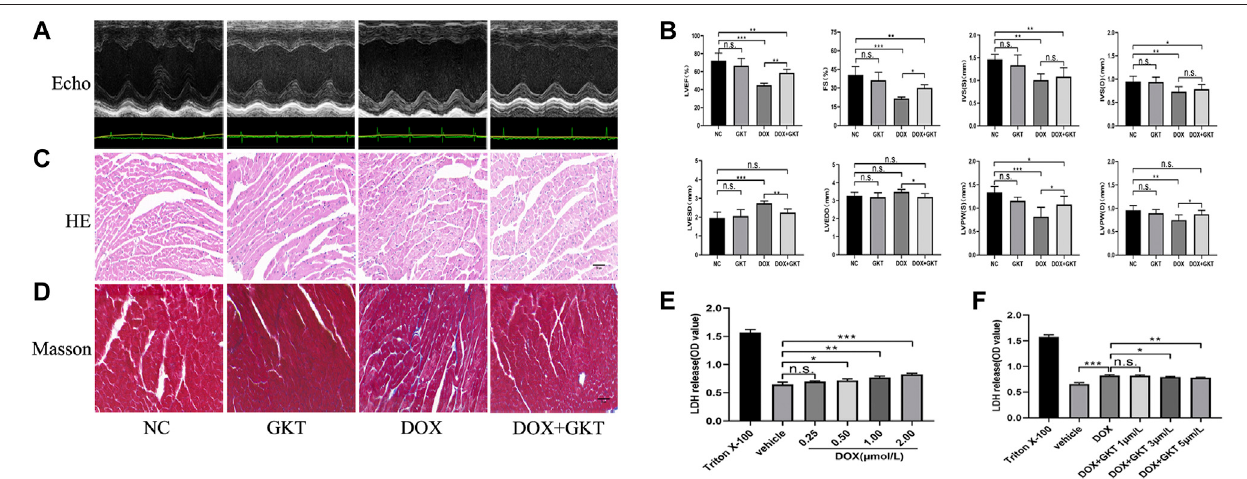
FIGURE 2 | GKT137831 alleviated DOX-induced cardiac dysfunction in vivo and attenuated diminished cell viability in vitro . (A) Representative M-mode echocardiograms. (B) EchocardiographicanalysisofLVEF,FS,IVSS,IVSD,LVESD,LVEDD,LVPWS,andLVPWD( n =5 – 6pergroup). (C,D) Representativeimageswith HE and Masson ’ s trichrome staining in myocardial tissue (scar bar = 50 µm). (E) NRCMs were stimulated with DOX for 24 h and followed by LDH assay to evaluate the cell viability ( n = 4). (F) NRCMs were pretreated with different concentrations of GKT for 1 h before DOX (2 μ M) stimulation. The cell viability was evaluated by LDH assay ( n = 4). * p < 0.05, ** p < 0.01, *** p < 0.001, n. s., not signi fi cant. Echo, echocardiography; DOX, doxorubicin; GKT, GKT137831; LVEF, left ventricular ejection fraction; FS, fractional shortening; IVSS, end-systolic inter-ventricular septal wall thickness; IVSD, end-diastolic inter-ventricular septal wall thickness; LVESD, left ventricularend-systolic diameter; LVEDD,left ventricular end-diastolic diameter; LVPWS, left ventricular end-systolic posterior wall; LVPWD, leftventricular end-diastolic posterior wall; LDH, lactic